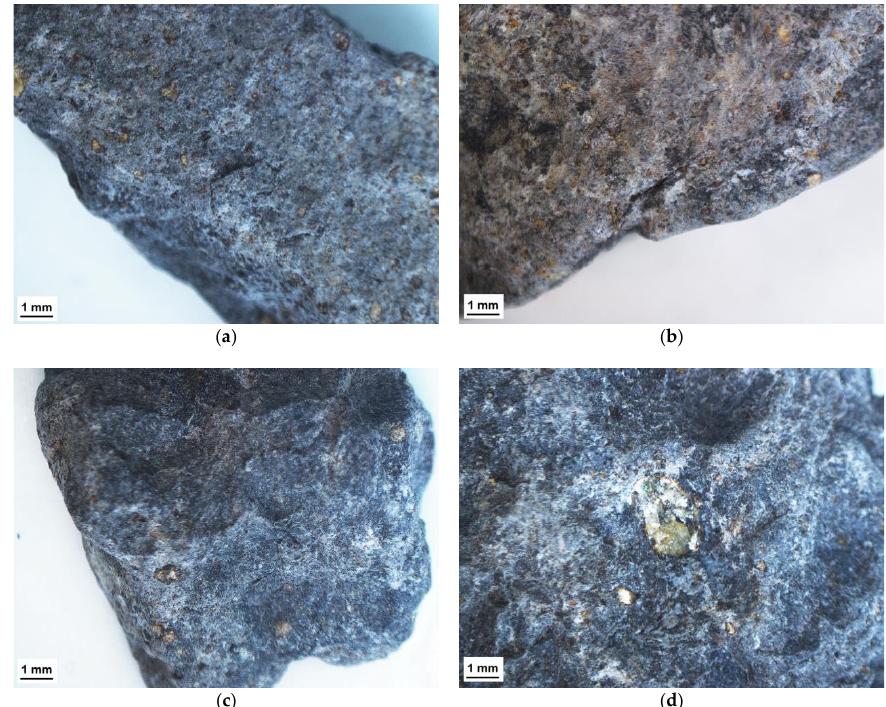
Figure A5. Characteristics of cracks in samples after crushing in jaw crusher (feed — flaky grains): ( a ) Basalt aggregate 1, non-flaky grains, +8 mm; ( b ) Basalt aggregate 1, non-flaky grains, +16 mm; ( c ) Basalt aggregate 1, flaky grains, +8 mm; ( d ) Basalt aggregate 1, flaky grains, +16 mm.